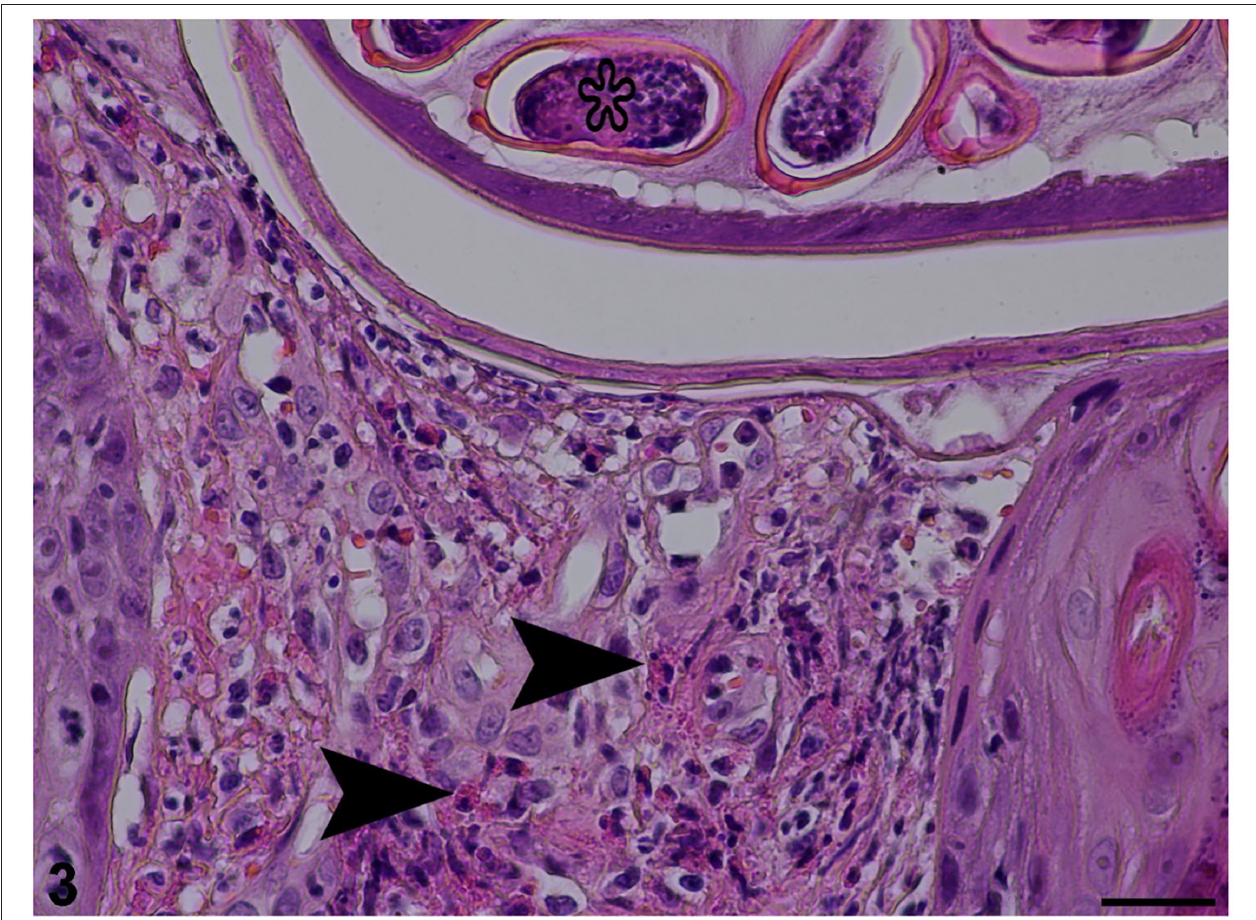
FIGURE 3 | Histopathological section stained with haematoxylin and eosin revealing inflammatory cell infiltration (arrowheads) in dermis and egg (star) in the uterus of an adult female (25 µ m scale